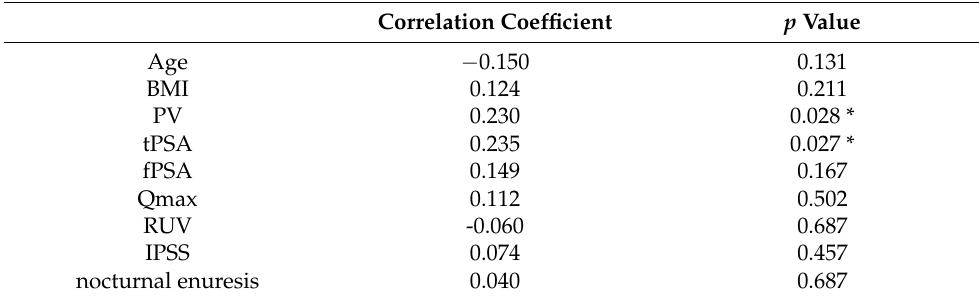
Table 6. The correlations between clinical parameters and CXCL13 expression of BPH patients.